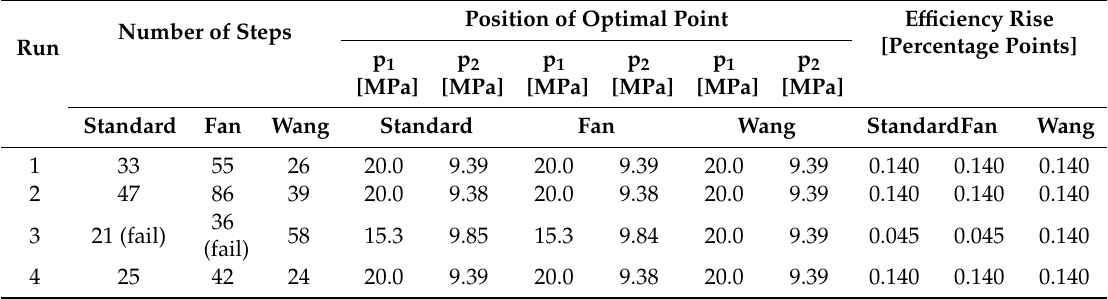
Table 5. The numbers of steps, positions of optimal points and rise in the efficiency for each NM configuration.